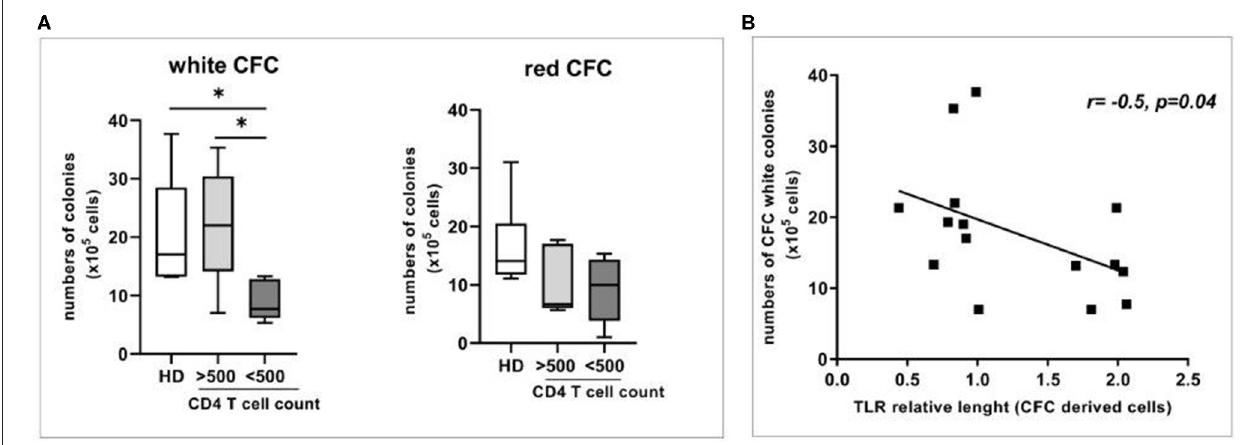
FIGURE 1 | Relative telomere length (RTL) and expansion/differentiation of circulating Hematopoietic Progenitor Cells (HPC) from HD, and HIV-infected patients ( < 500 and > 500 CD4T cell count). (A) Colony forming cell assay (CFC) showing the numbers of white and red colonies (left and right panel) generated from circulating HPC from HD ( n = 8) and from HIV-infected patients ( n = 15). (B) Correlation between relative telomere length and numbers of CFC white colonies in HD and HIV-infected subjects. Mann–Whitney test, * p < 0.05.